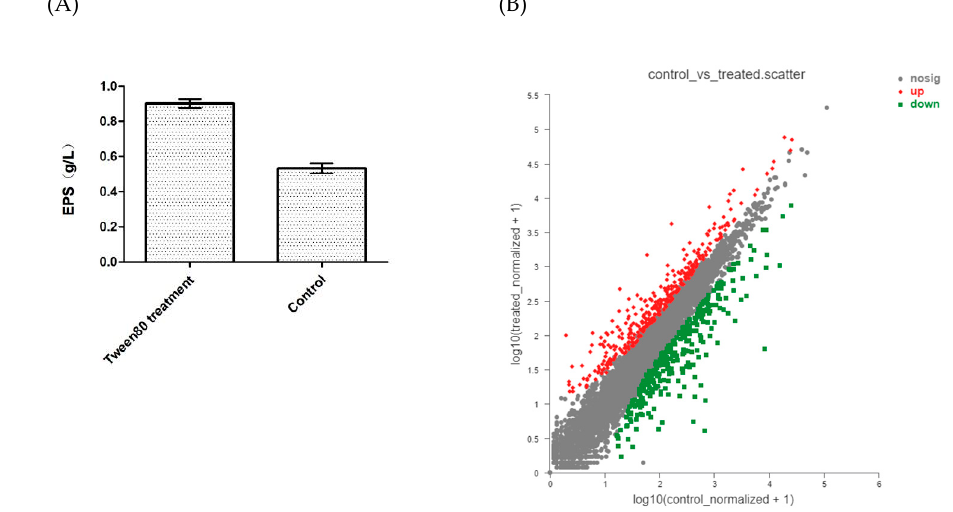
Figure 4. The content of exopolysaccharides ( A ) and the comparison of DEG expression between Tween80-treated group and control group ( B ).